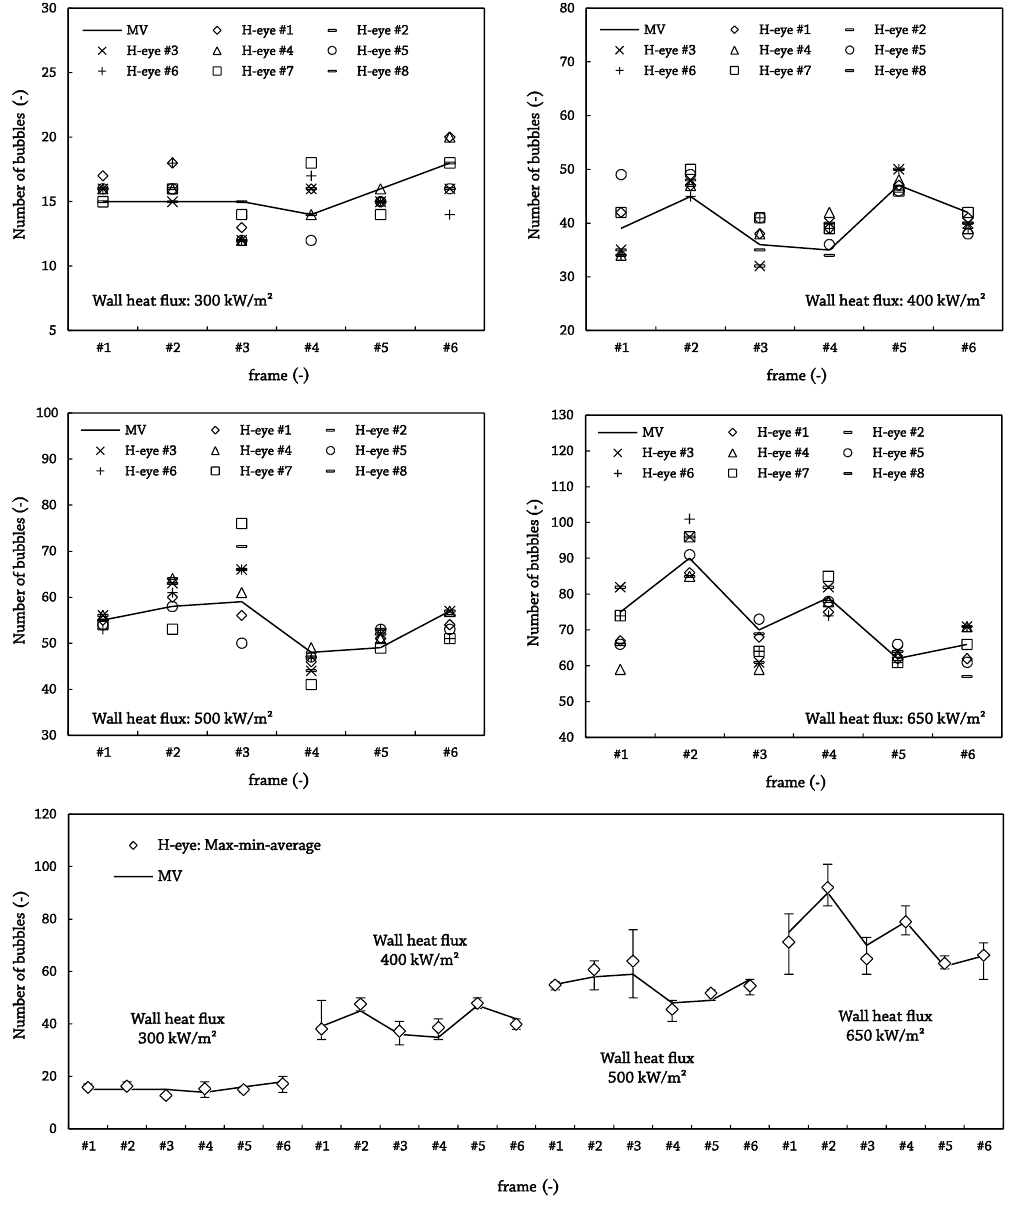
Figure 14. Validation results MV vs. human-eye for selected frames covering the full range of wall heat flux. Bottom: maximum, minimum and average value for all of the human observations and MV output. Top and middle: human single observations and MV output for the four selected values for the heat flux.